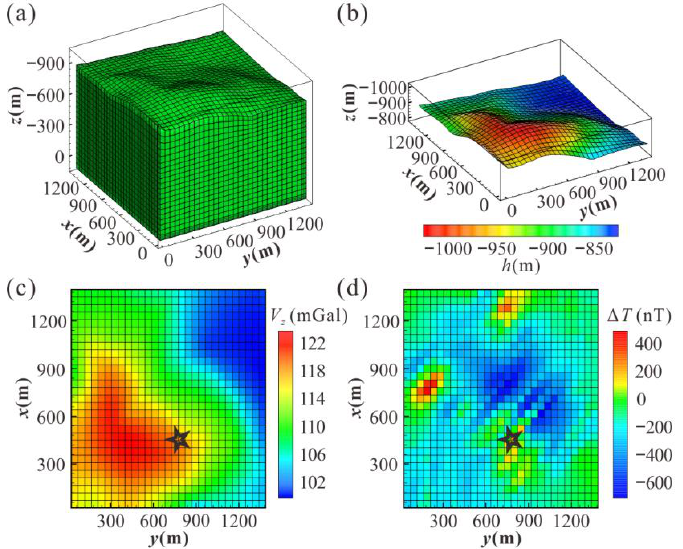
Figure 20. ( a ) Model division; ( b ) topographic relief; ( c , d ) observation data. The black stars indicate the location of the proven skarn deposit.